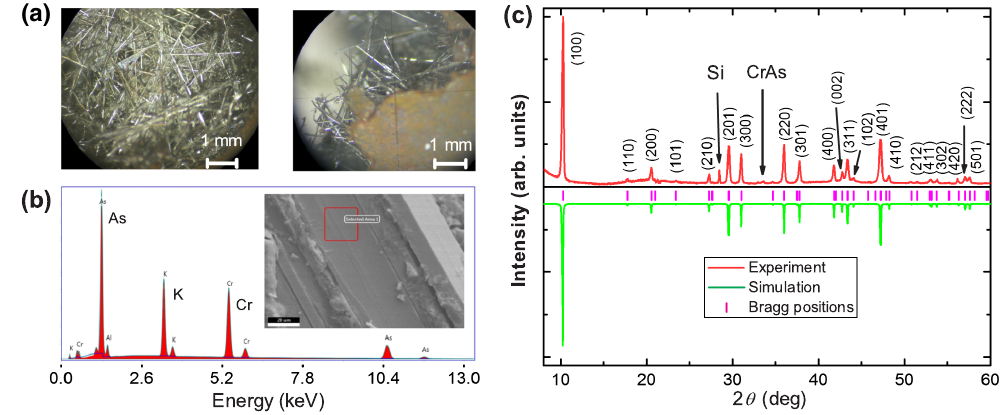
FIG. 1. Characterizations of the K 2 Cr 3 As 3 samples. (a) Morphology of a batch of the as-grown crystals under an optical microscope (left: top view; right: side view). (b) A typical energy-dispersive x-ray spectrum with electron beams focused on the selected area (marked in the inset) of the as-grown crystals. A small amount of the element Al comes from the sample holder. (c) Powder x-ray diffraction of the polycrystalline samples indexed by the hexagonal unit cell determined from the single-crystal diffractions. Si is added as an internal standard. Only a small amount of the CrAs impurity is identified. The simulated pattern (with the consideration of preferential orientations of crystalline grains) well reproduces the experimental